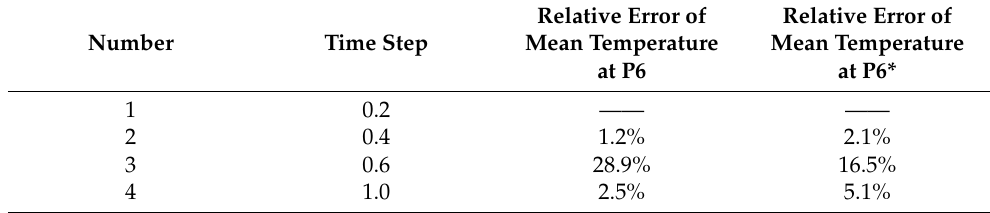
Table 2. Step size independence